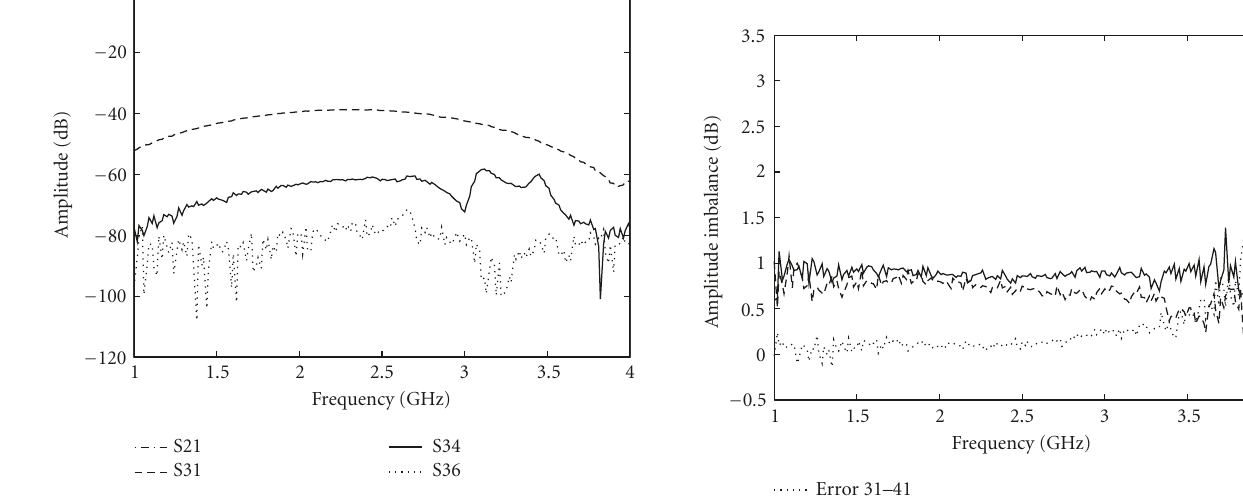
Figure 17: The measured performance of the prototype 2 × 2 cou- pler.